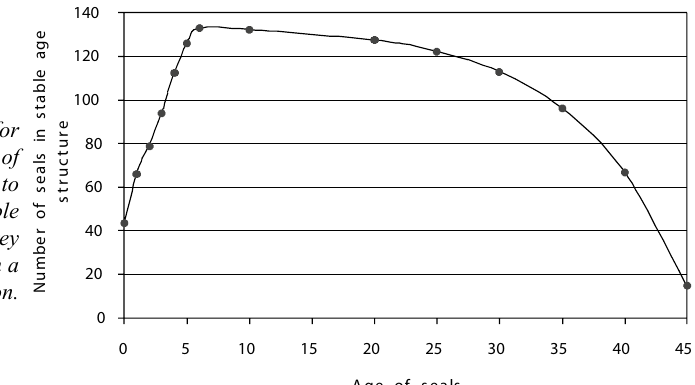
e Fig. 13. The value of an individual female seal for u r future population growth depends on age. A hunt of t 100 females of a given age (x-axis) corresponds to a number of ‘mean females’ (according to the stable age distribution) (y-axis). A hunt of 100 Baltic grey seal pups corresponds to a hunt of 40 females with a stable age